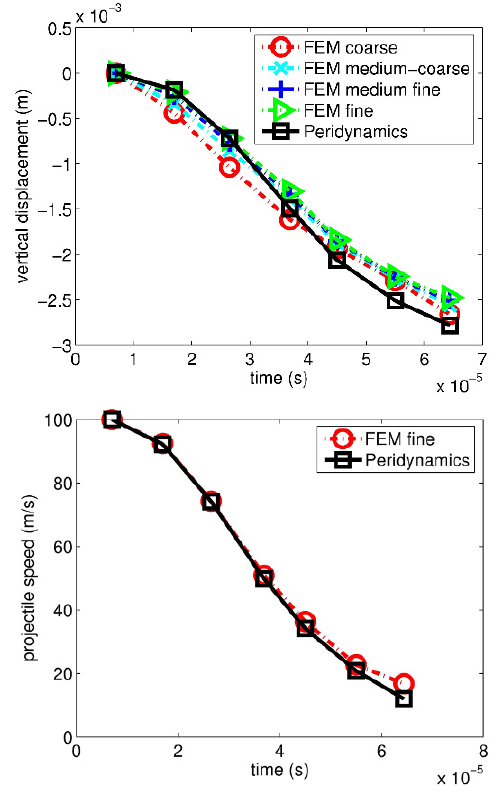
Figure 3. Elastic impact of a rigid sphere onto a two-layer glass with a PC backing system. Top: comparison of the vertical dis- placement for the centroid of the first glass layer between the finite element method and peridynamics. Bottom: pro- jectile velocity